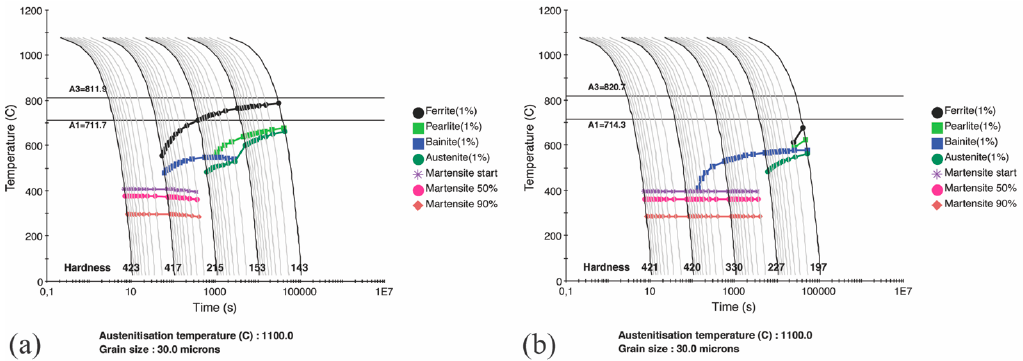
Figure 3. CCT diagrams constructed using JMatPro software. ( a ) 0Mo, ( b ) 0.5Mo, no deformation, austenite grain size 30 μ m.